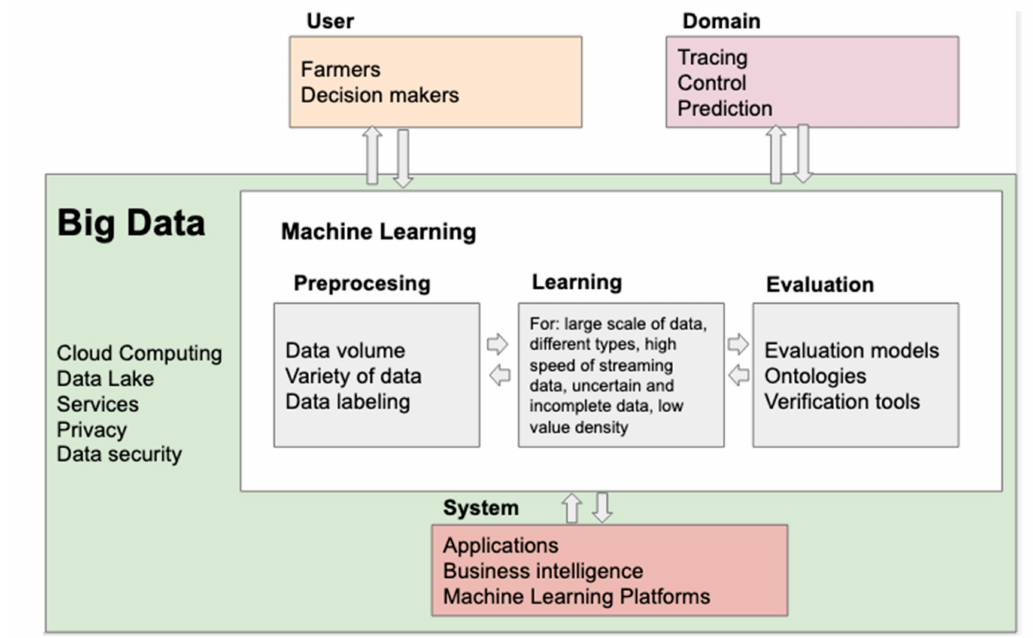
Figure 20. A framework of Machine Learning and Big Data challenges in